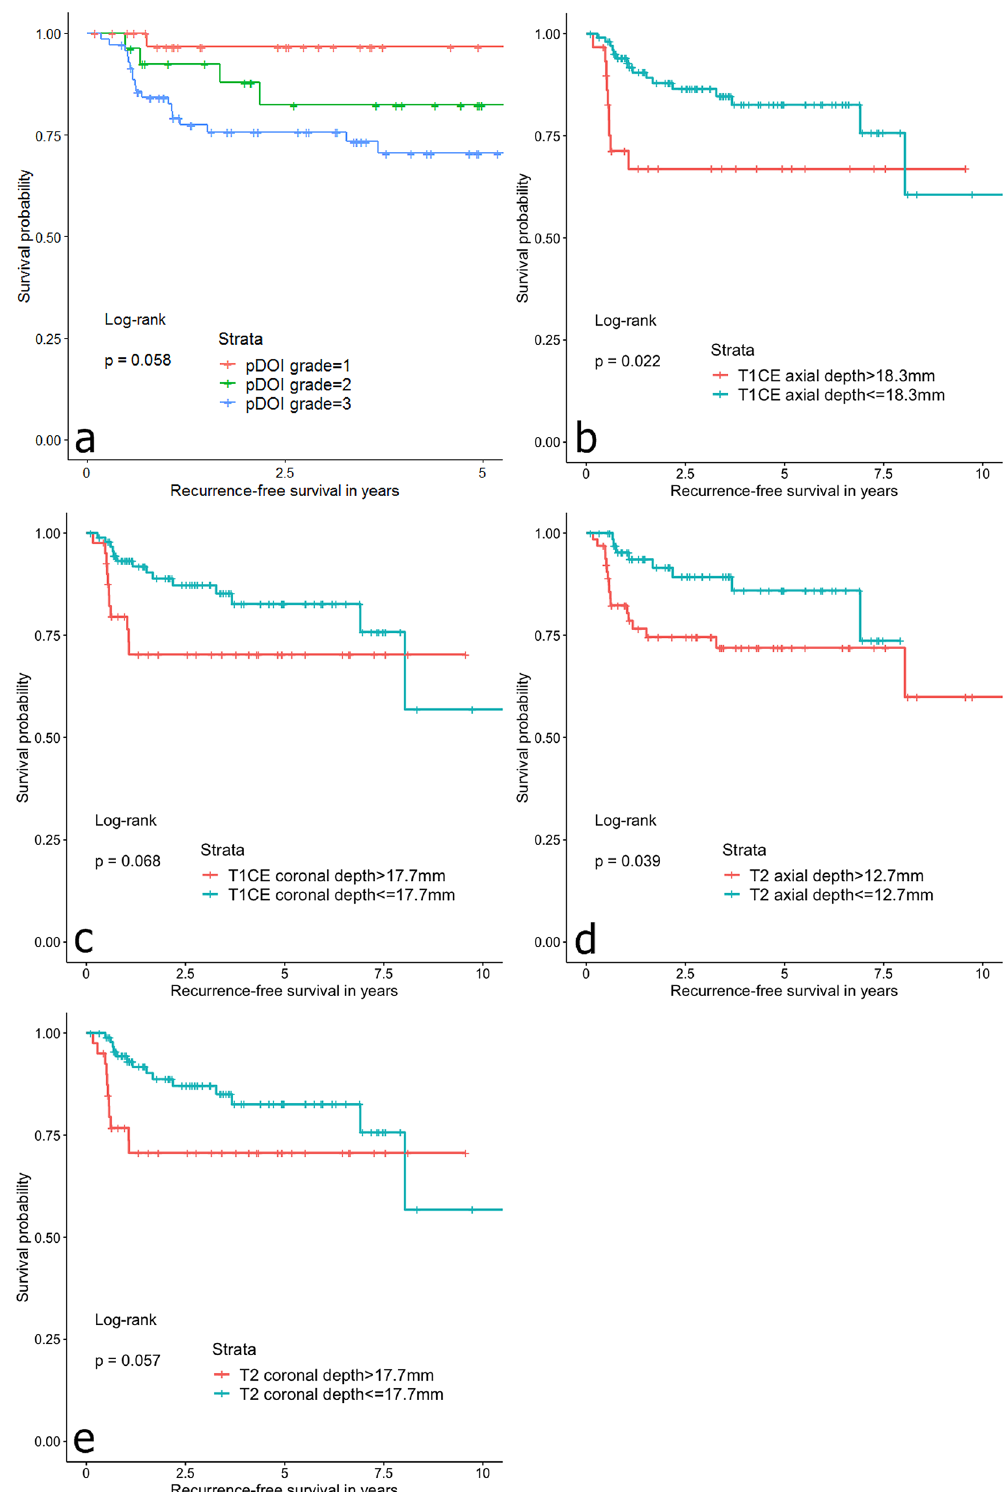
Figure 4. Kaplan–Meier curves for recurrence-free survivals based on ( a ) pathologic depth of invasion (pDOI) grades, ( b ) axial CE-T1WI, ( c ) coronal CE-T1WI, ( d ) axial T2WI, and ( e ) coronal T2WI, stratified by the thicknesses